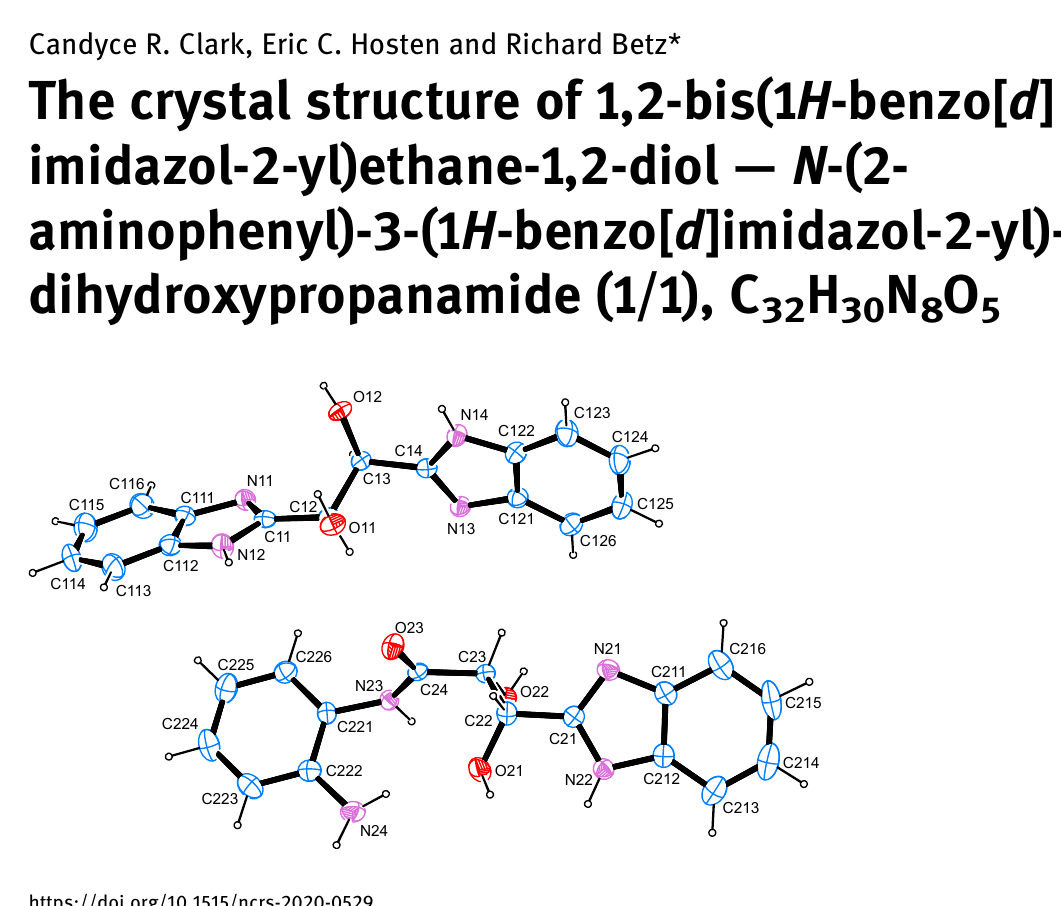
Table  : Data collection and handling. Crystal: Colourless